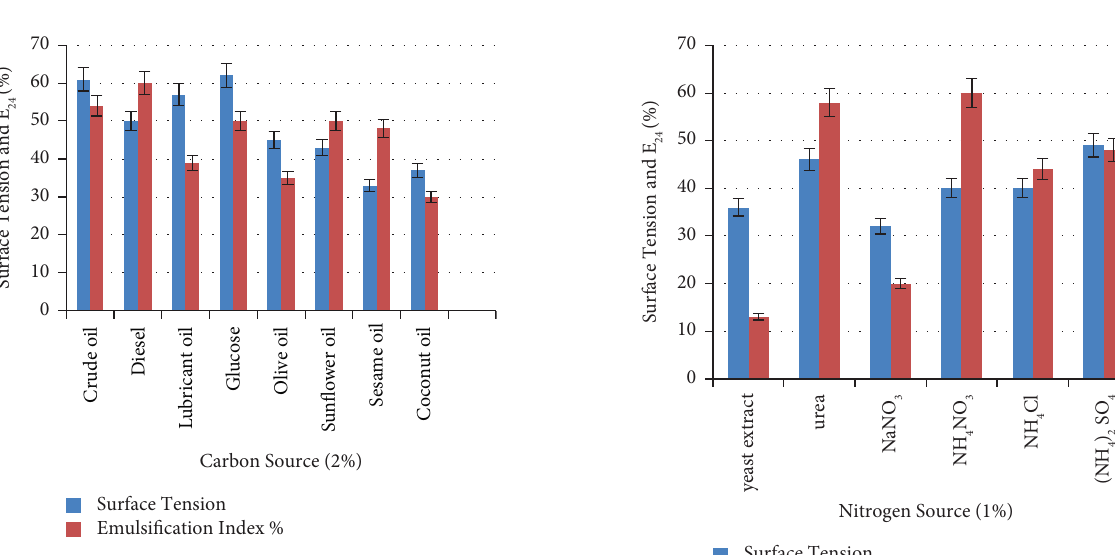
Figure 7: Efect of diferent carbon sources on biosurfactant production. Sesame oil is the best with E 24 % (48 ± 0.33%) and the lowest surface tension (33 ± 0.67mN/m).